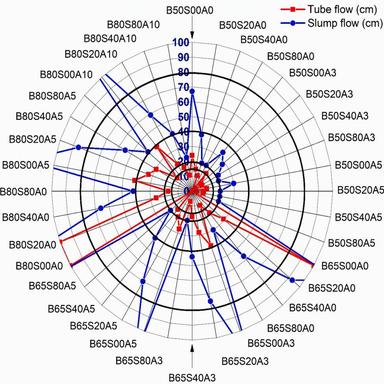
Radar chart of both tube flow and slump flow for the CLSM mixtures.